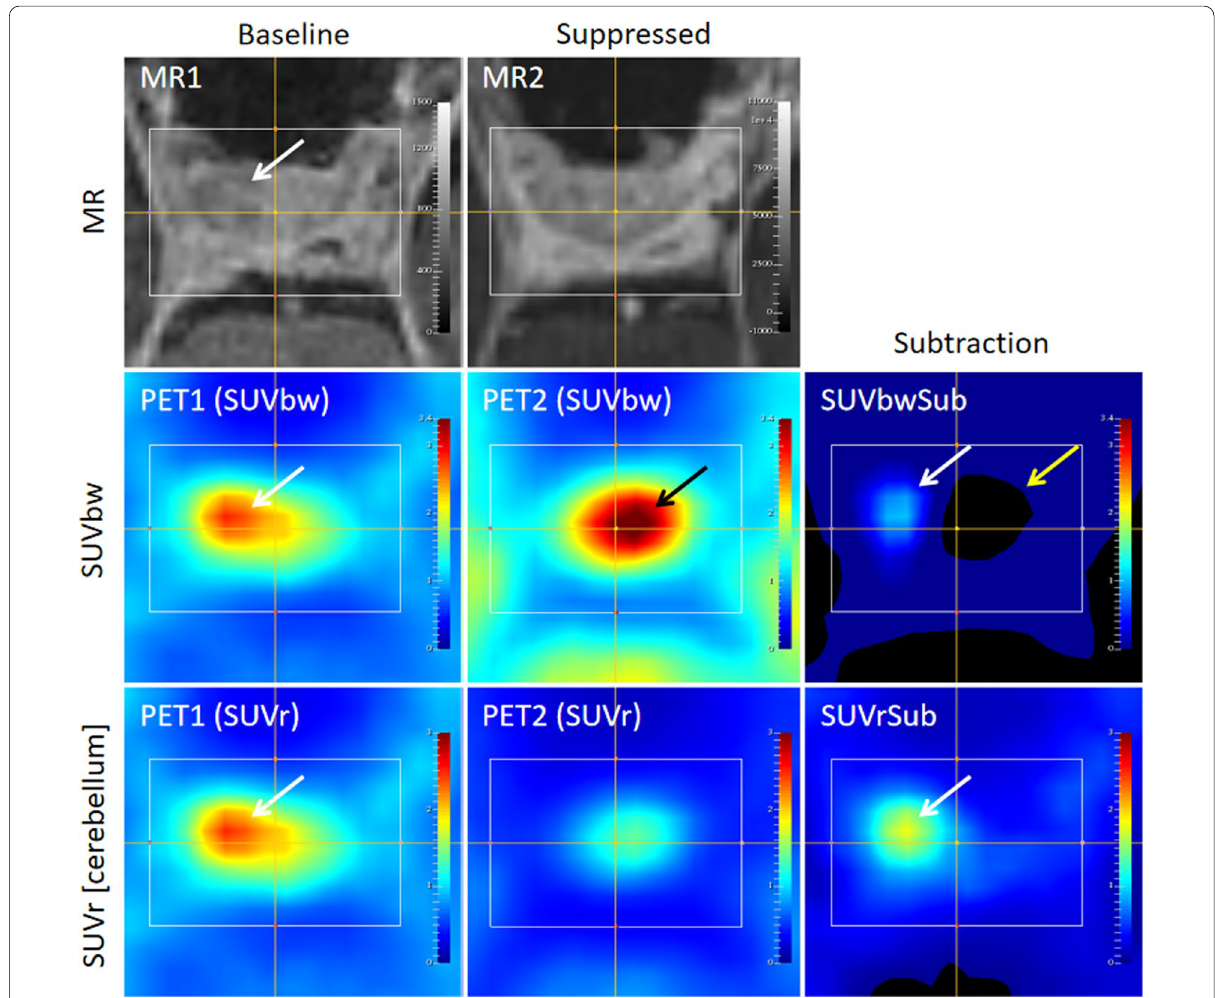
Fig. 7 Findings in subject 4. The white arrows highlight the site of the suspected pituitary tumor on the baseline MR (MR1), the skewed tracer distribution of the baseline Met-PET (PET1) and the focal signal seen on the subtraction images. The black arrow highlights the variability of the Met-PET signal, and the yellow arrow highlights the effect of this on the subtraction image; the SUVbw values of the suppressed Met-PET are higher than those of the baseline, and therefore, the difference between them (seen in the SUVbwSub image) is not as pronounced as that of the normalized images (seen in the SUVrSub [cerebellum]